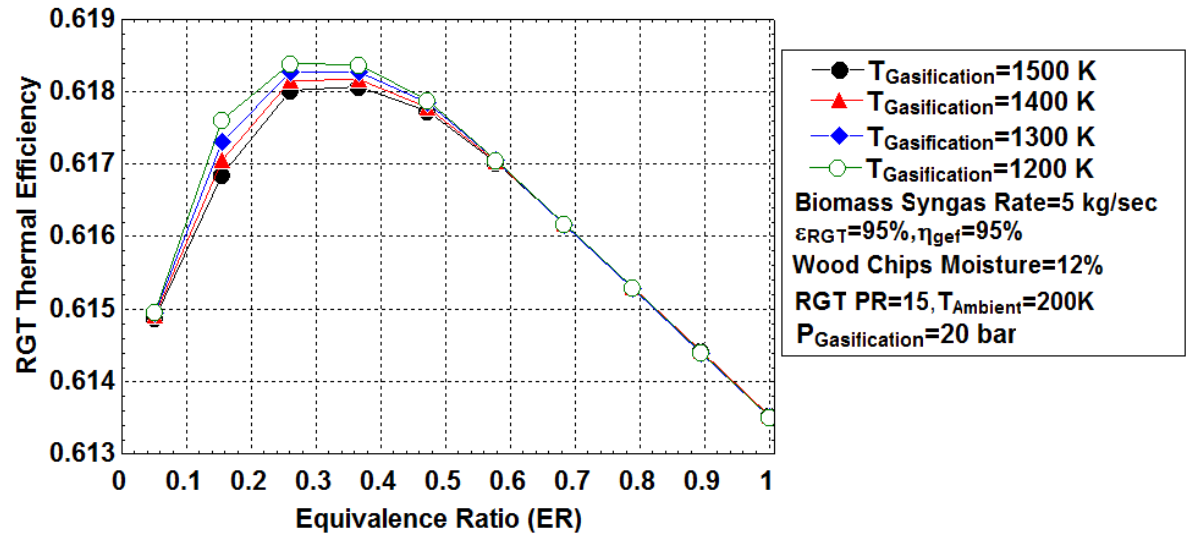
Figure 5. Effect of the equivalence ratio on the RGT thermal efficiency for different gasification tem- peratures.